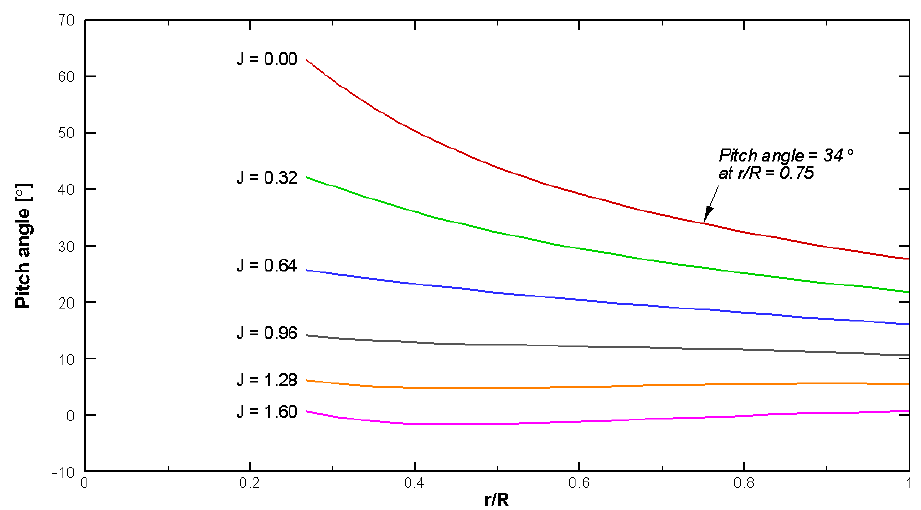
Figure 8. The angle of the resultant flow of the blade section as a function of the advance-ratio change at a representative pitch angle of 30°.